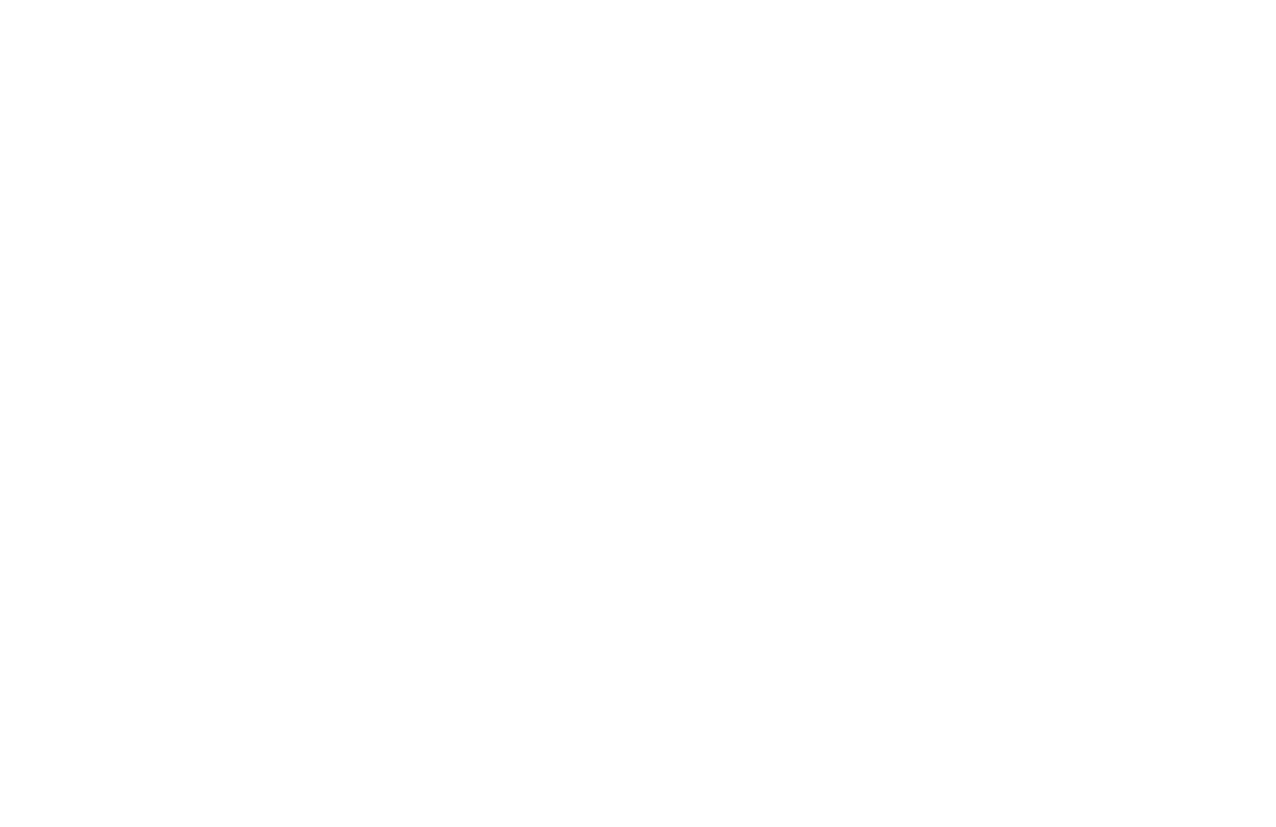
FIGUREA1 | Schematic overview of the study design. Abbreviations: CT, computed tomography; 6MWT, 6-min walk test; 6MWD, 6-min walk distance; SpO 2 , peripheral oxyhemoglobin saturation. a Thirty eight subjects did not complete 2-year follow-up of 6MWT: 16 were lost to